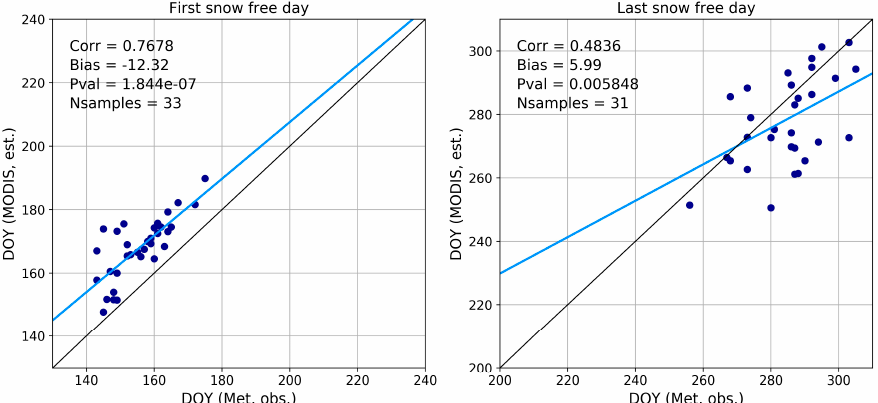
Figure 9. Comparison of the first (left) and last (right) snow-free day estimates derived from snow depth measurements made at the six observational sites listed in Table 1 and those derived from the Moderate Resolution Imaging Spectroradiometer (MODIS) snow cover fraction product. Both datasets have been filtered to exclude estimates during the polar night period (DOY > 306) where MODIS data are unavailable. The black line indicates where the estimates would be equal and the linear regression result is highlighted by the solid blue line.